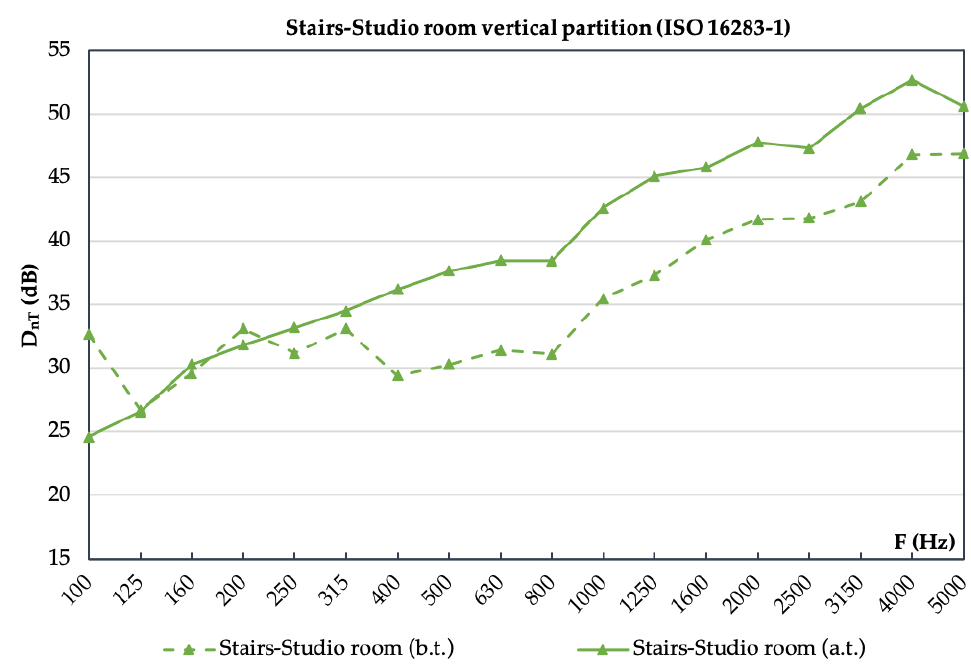
Figure 17. Standardized level difference of the stairs–studio room vertical partition. Table 10. Weighted standardized level difference values for the stairs–studio room vertical partition, before and after treatment.